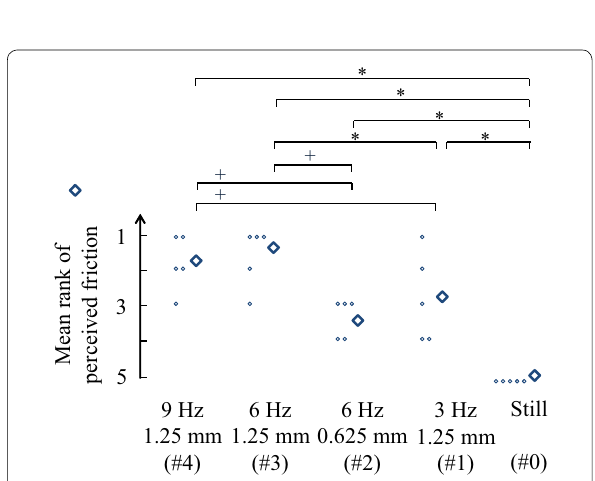
Fig. 9 Order of perceived friction when ˙ x f = 0.04 m/s and ˙ x r ( t ) can be zero. *p < 0.05, + p < 0.10 (Steel-Dwass test). The smaller dots sig- nify the ranks reported by the individuals, while the larger diamonds signify the mean ranks for all the